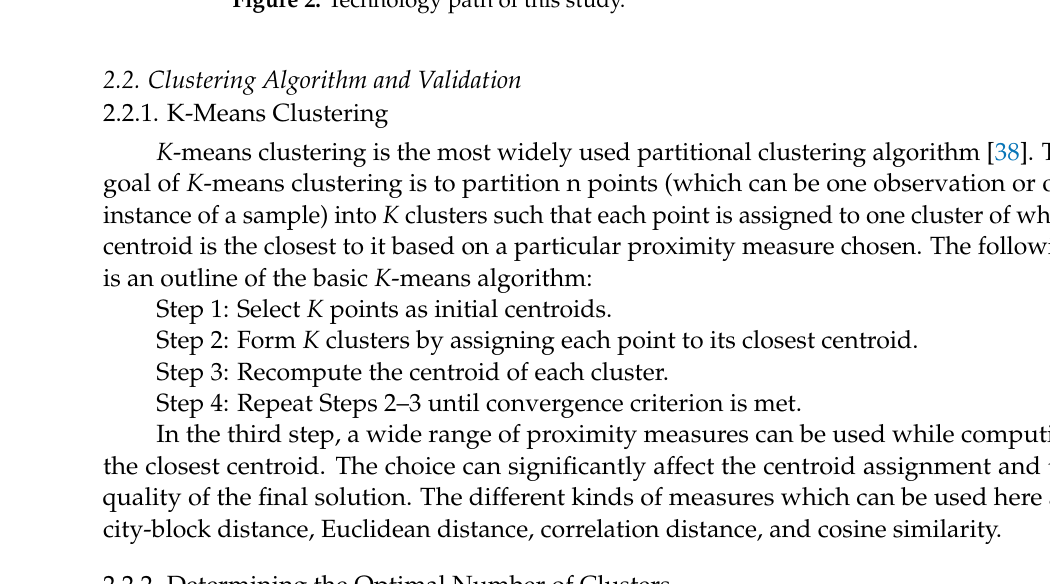
Figure 2. technology path of this study. Figure 2. Technology path of this